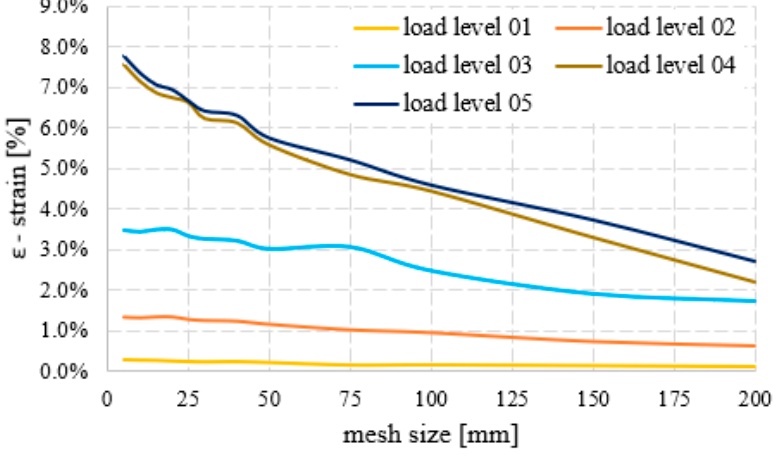
Figure 16. Maximum strains in the stress concentration zone depending on mesh size.